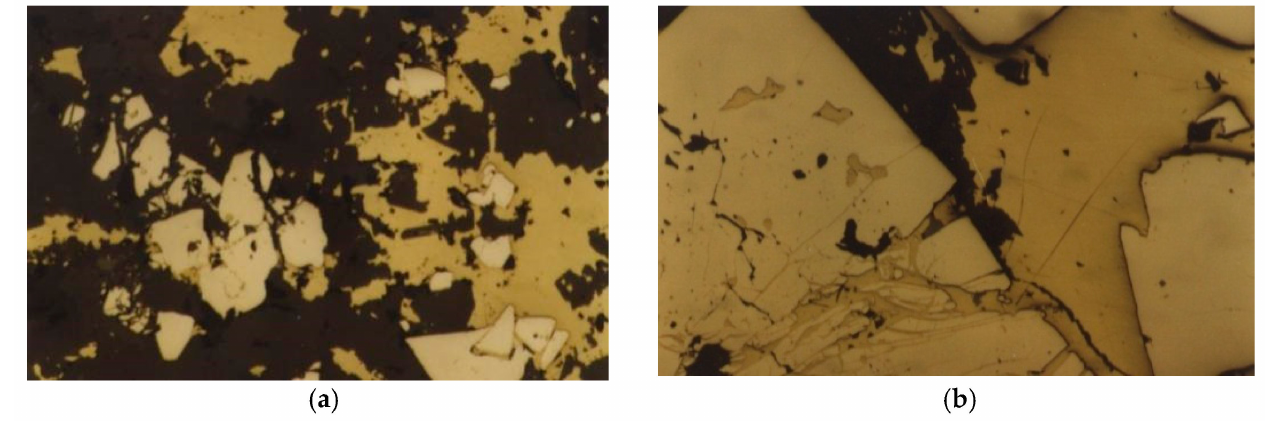
Figure 1. ( a ) Chalcopyrite. Yellow—independently in the form of xenomorphic grains; light yellow—in association with pyrite; black-gray—interspersed in vein minerals. Reflection is 260 × . ( b ) Chalcopyrite. Yellow—in pyrite cracks; light yellow—in the form of thin veins. Reflection is 260 × .